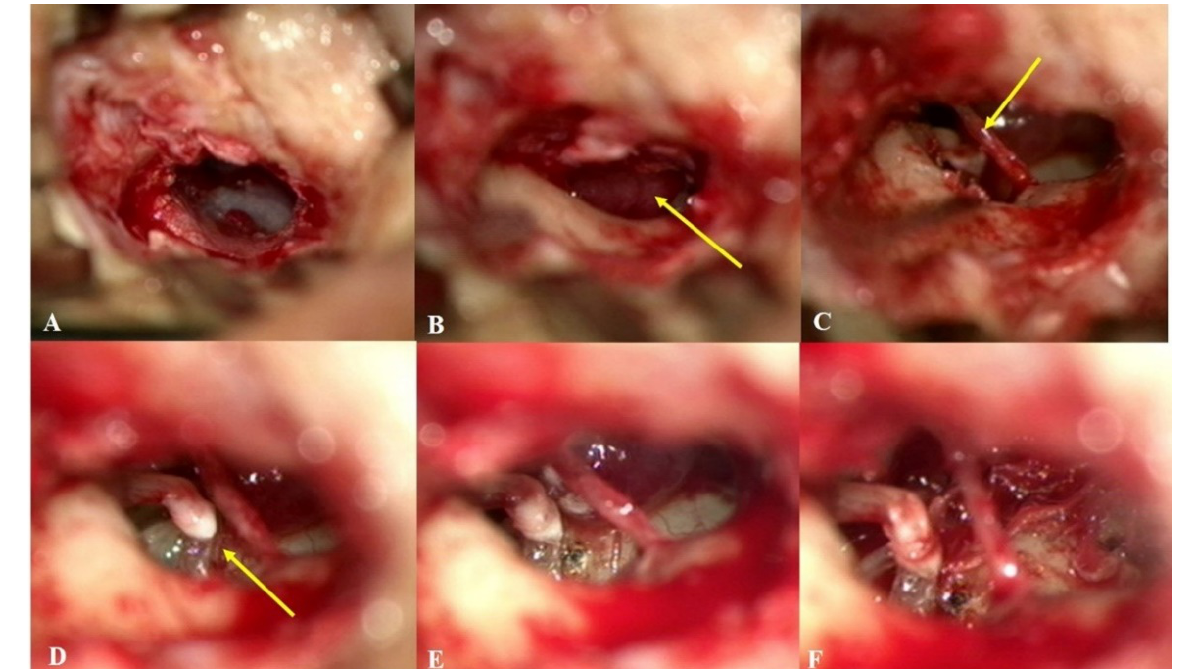
Figure 3. Intraoperative microscopic images of subject 8. ( A ) An endaural approach was chosen in this case. ( B ) After the